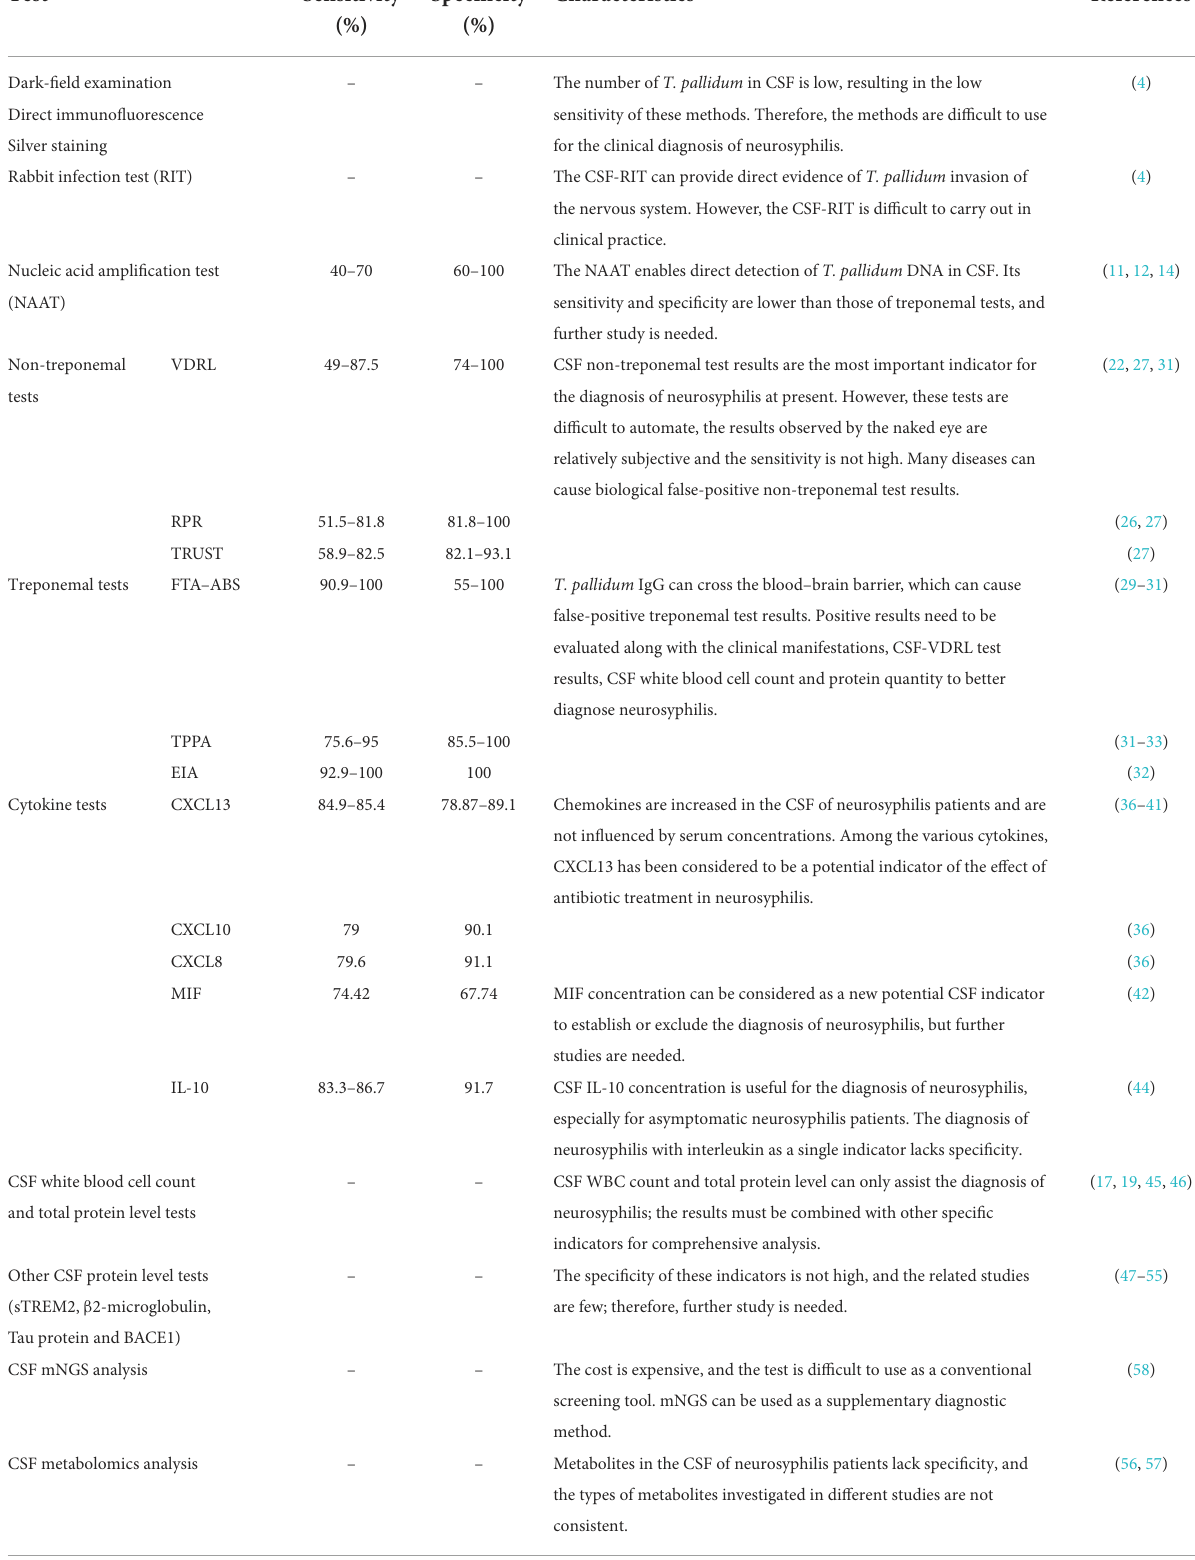
TABLE 1 Summary of the performance characteristics for the different CSF tests in